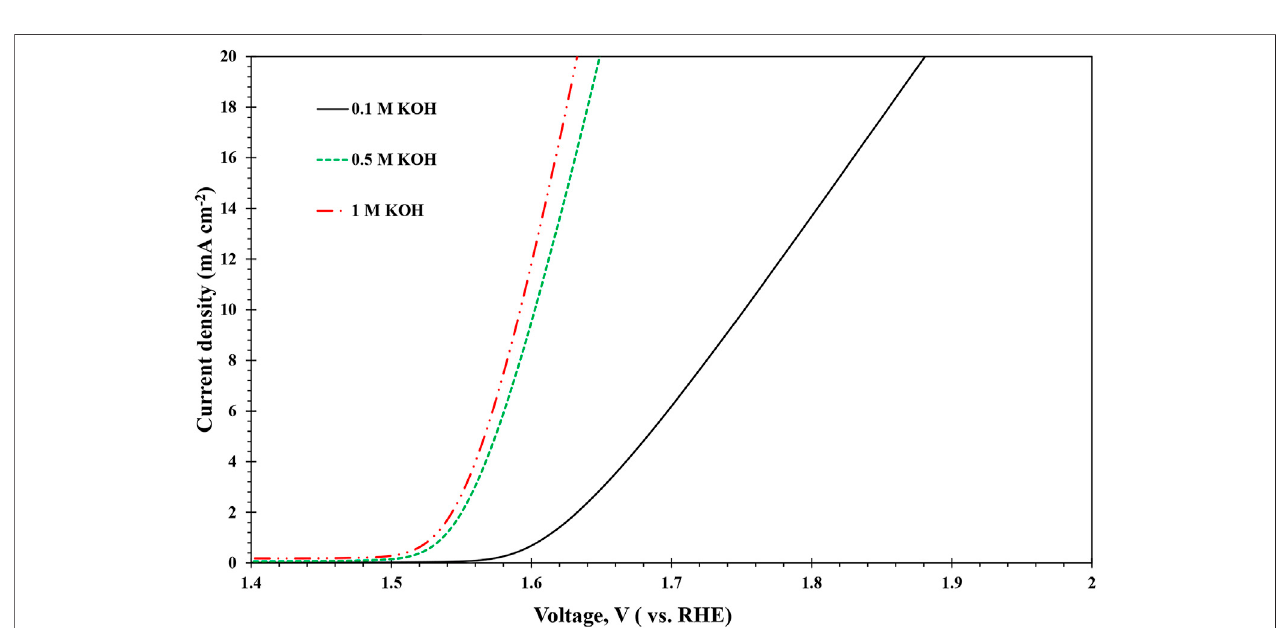
FIGURE 2 | The performance of stainless-steel WE for OER in different concentrations of KOH electrolytes.